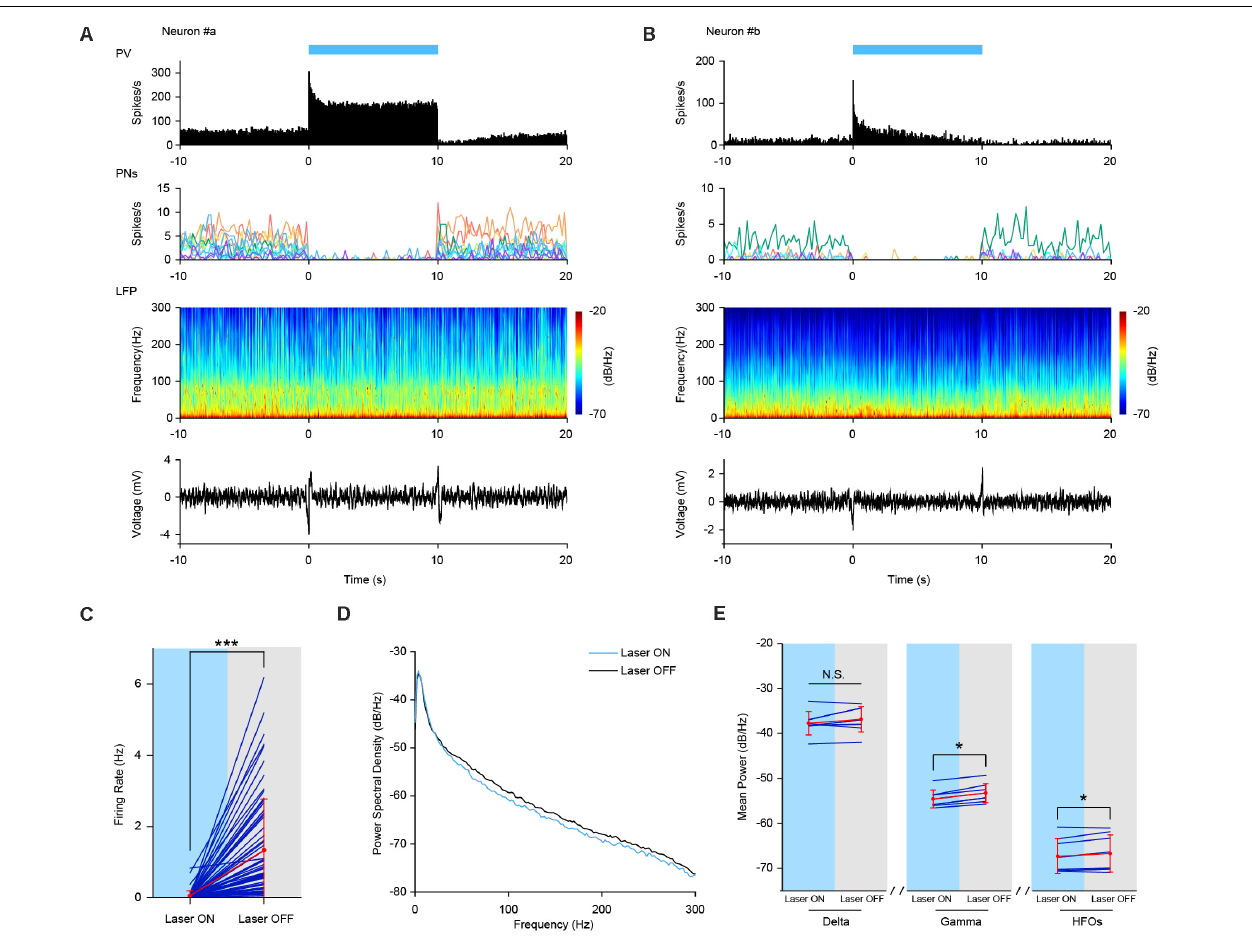
FIGURE 5 | Increased Firing activities of PV interneurons by sustained optogenetic stimulation. (A,B) Neuronal firing activities of two example PV interneurons upon optogenetic stimulation in PV-ChR2-EYFP mice during AE and SWS state, respectively. Top row, neuronal firing responses of PV interneurons to sustained laser stimulation (10 s, bin = 0.05 s). Second row, neuronal firing activities of simultaneously recorded pyramidal neurons (PNs). Each colored line represents firing rate activities of one pyramidal neuron [ n = 11 PNs in (A) and n = 7 PNs in (B) , bin = 0.2 s]. Third row, power spectrogram of PFC LFP. Bottom row, responses of PFC LFP to sustained laser stimulation. (C) Mean firing rate of simultaneously recorded prefrontal pyramidal neurons during sustained laser stimulation of PV interneurons. Red, mean ± SD; navy, individual; the same below (Wilcoxon Signed Ranks Test, ***, p = 3.5e-12, based on negative ranks, n = 65 neurons). (D) PSD of PFC LFP upon laser stimulation of PV interneurons during SWS state. Oscillation power at high frequency range (including gamma and high frequency oscillations) was slightly lower than that without stimulation. (E) Statistical test of mean power of different oscillations with and without sustained laser stimulation (Wilcoxon Signed Ranks Test, p delta = 0.123, *, p gamma = 0.012, p HFOs = 0.049, n = 8